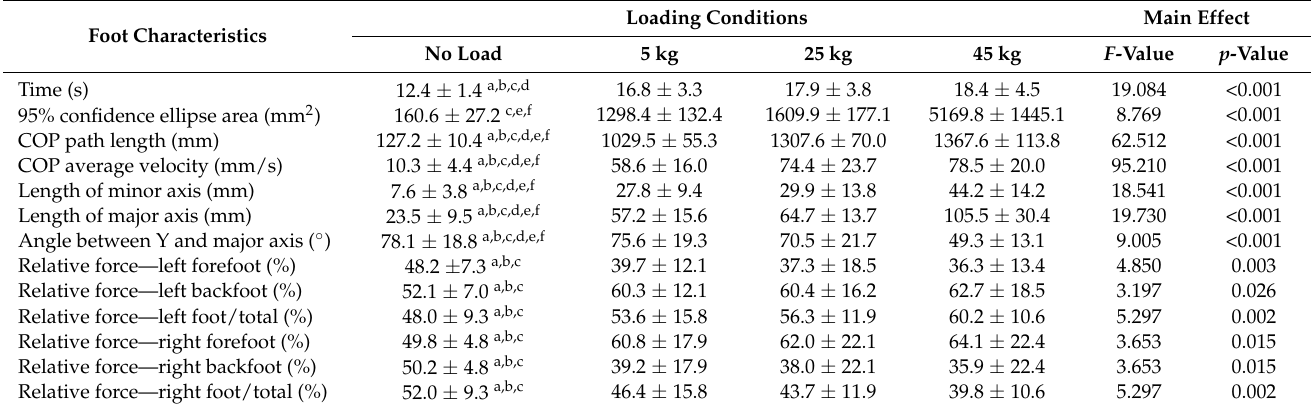
Table 2. Effects of load carriage on postural sway characteristics in special police officers ( n =